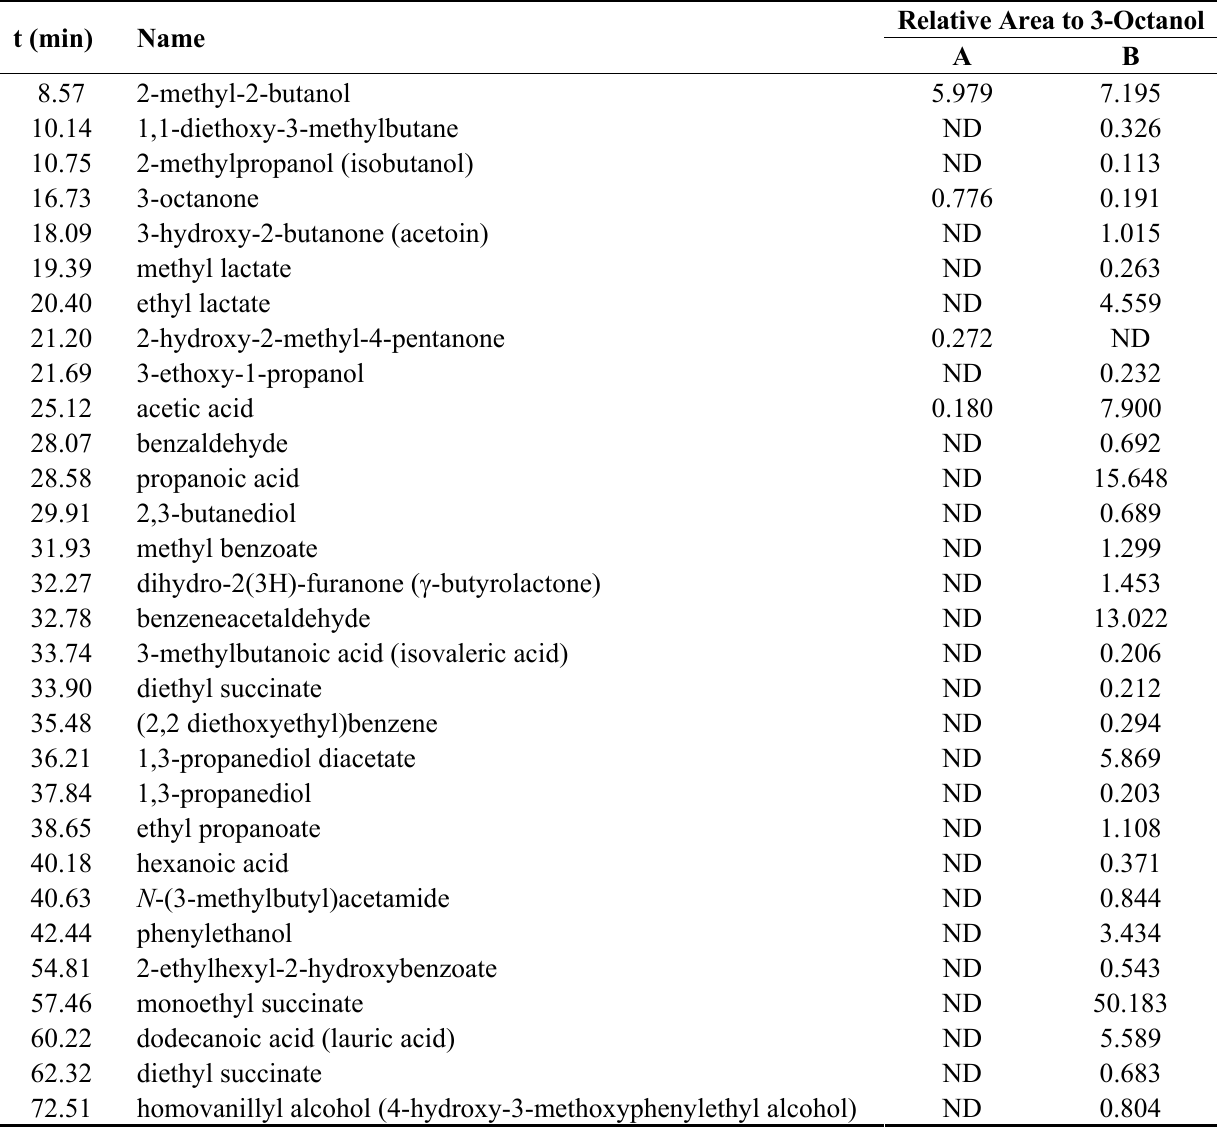
Table 7. Composition of the DCM soluble fractions from the liquid phase separated from winery wastes further diluted (A) and from the product desorbed from Sepabeads SP207 with 96% ethanol at 50 °C (B), analysed by